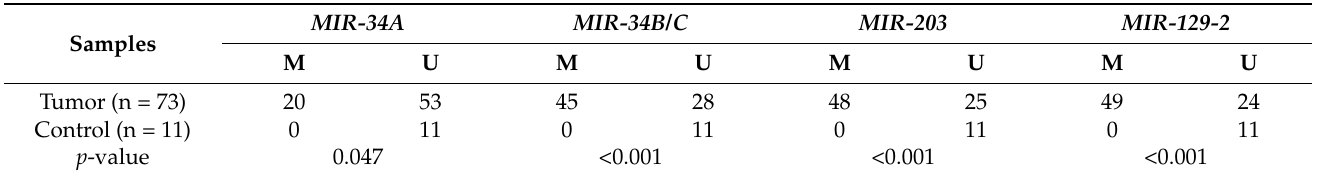
Table 1. Methylation of the MIR-34A , MIR-34B/C , MIR-203 and MIR-129-2 genes’ frequencies in the tumor and control samples.